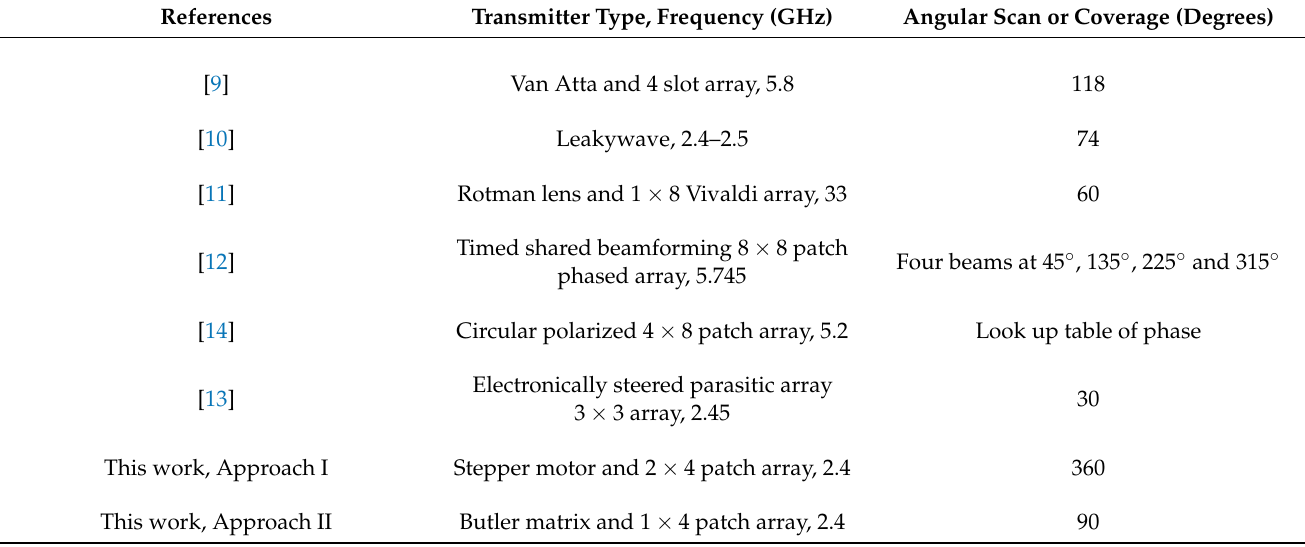
Table 1. Wireless power transfer via directive beam